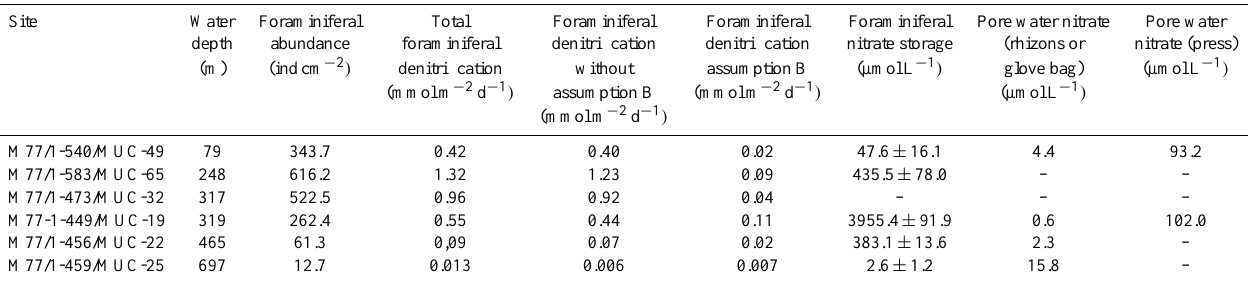
Table 4. Estimated total benthic foraminiferal denitrification rates and nitrate storage at the different sampling sites. The column “foraminiferal denitrification without assumption B” covers the foraminiferal denitrification for species where literature data for the in- dividual rates was available plus the denitrification rates derived by assumption A. Also listed are foraminiferal abundances and pore water nitrate concentrations in the top centimetres of the sediments. The elevated pore water nitrate concentrations in samples from the pore water press most probably result from squashed foraminiferal as well as Thioploca and Beggiotoa cells. Errors of foraminiferal nitrate storage are based on the standard errors of the mean (SEM) from Pi˜na-Ochoa et al.